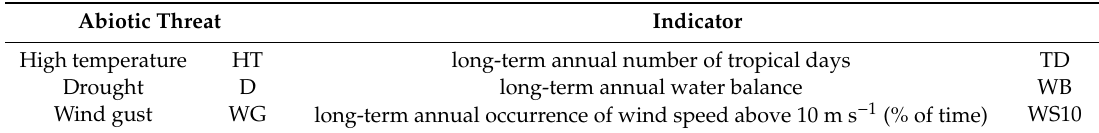
Table 1. Individual abiotic threats and their indicators.